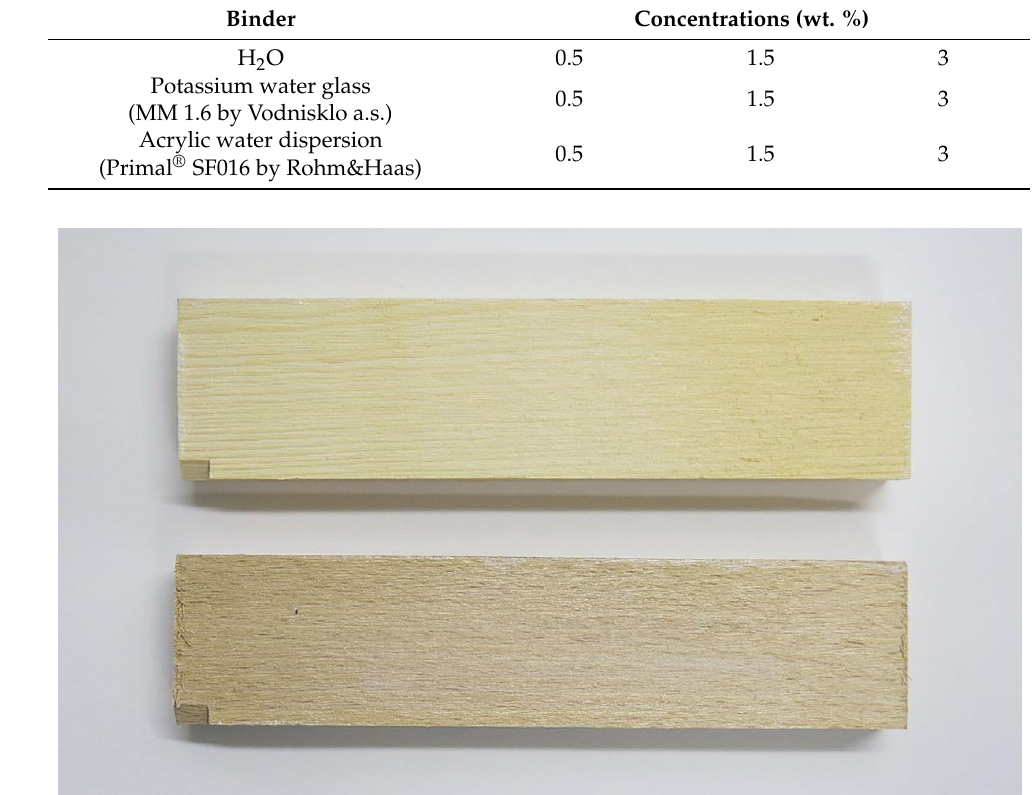
Figure 3. Pine wood and beech wood specimens coated with 1 wt. % of TiO 2 acrylic dispersion. Phot. P. Svora.